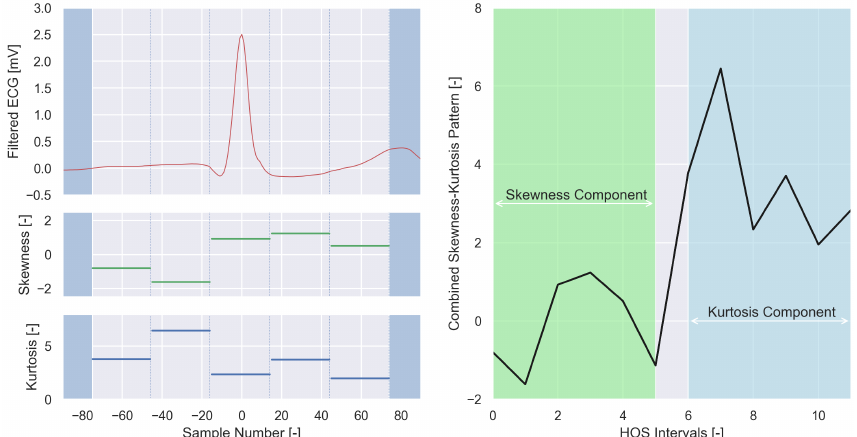
Figure 4. Higher-Order Statistics (HOS) cumulants example of the merged database, which was created dividing each beach into five intervals and then computing the kurtosis and skewness values for each of them as the results give morphological ECG description features of the